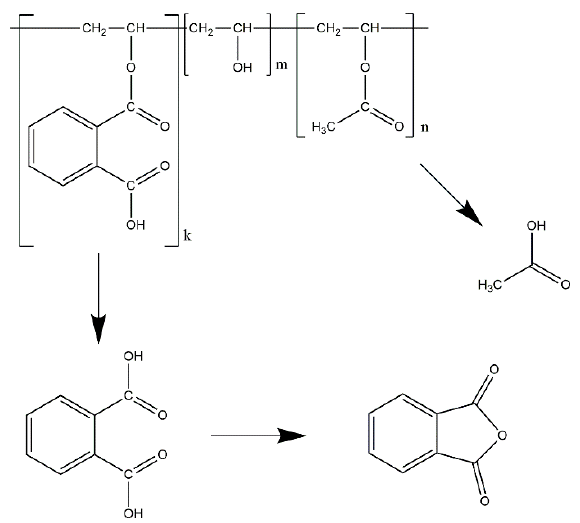
Figure 1. Chemical structure of polyvinyl acetate phthalate (PVAP) including a possible heat-induced degradation pathway.